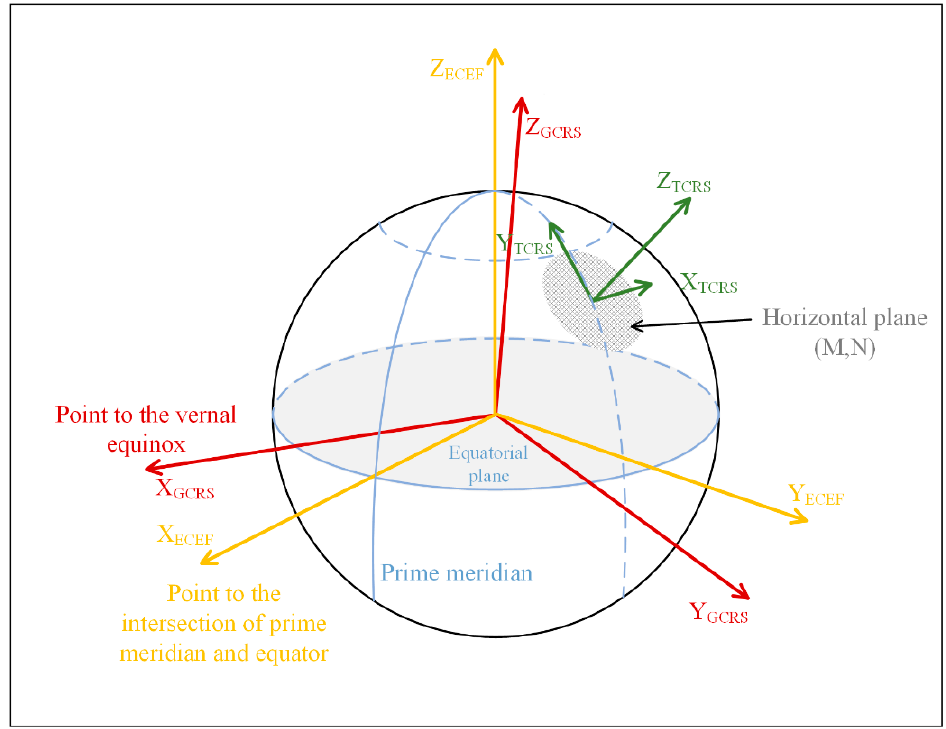
Figure 4. Diagram of Earth showing the relationship of three coordinate systems.